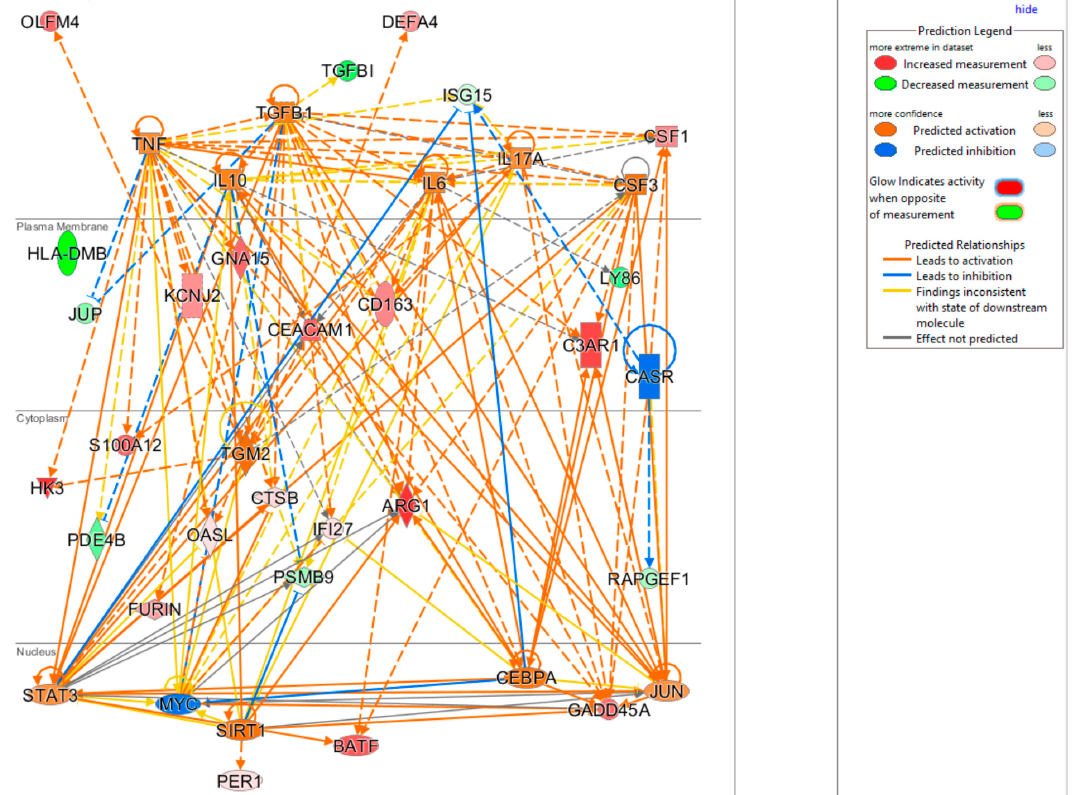
Figure 4. Cellular view of a regulator network for 29 input genes. This network was derived based on the knowledge base in IPA with InSep 29 markers as input for bacterial infection.